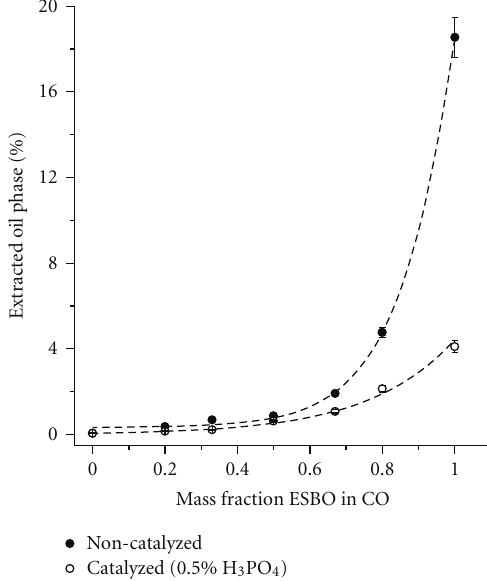
Figure 3: Extractability trend of urethane elastomers based on catalyzed and noncatalyzed ESBO. Urethane materials were formed from the reaction of ESPs (epoxide and castor oil) and polymeric MDI. Curing conditions were at 45 ◦ C for 48 h in a convection